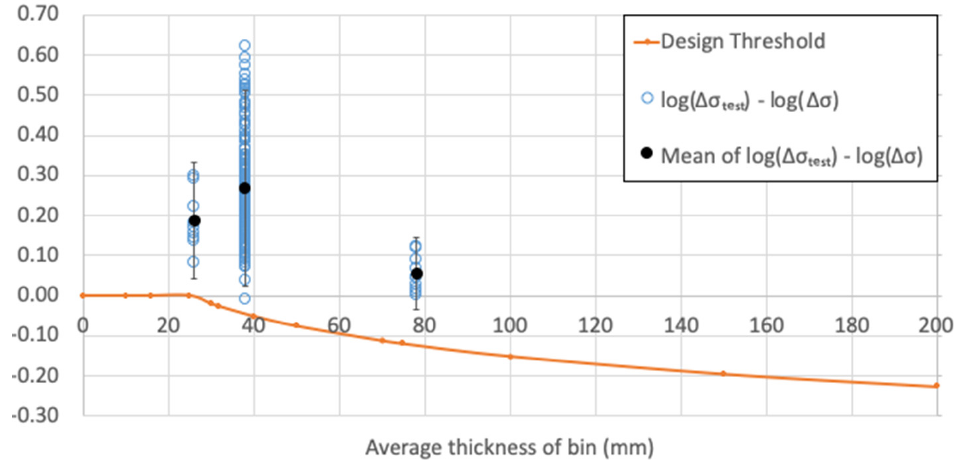
Figure 10. Data analysis of CP T-joints .